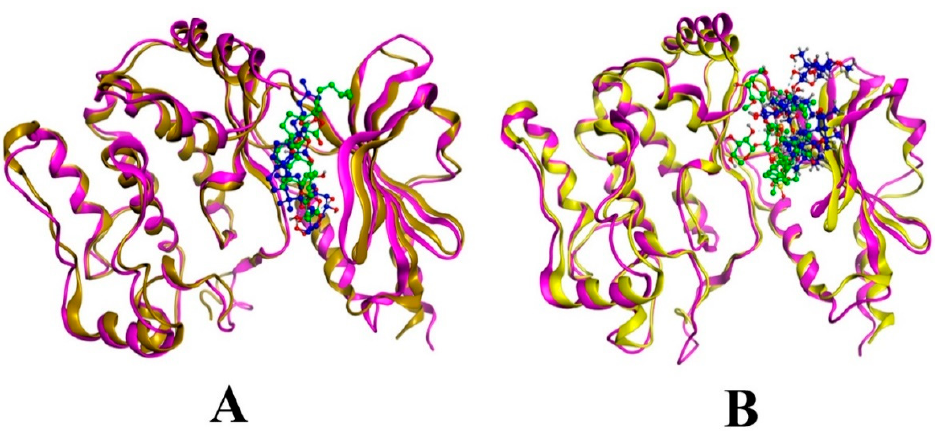
Figure 6. Ligand-protein complex poses after 20 ns molecular dynamics (MD) simulation compared to that of docked complexes. Receptor after molecular docking simulation: yellow; Receptor after 20 ns MD simulation: pink; Ligand after molecular docking simulation: green; Ligand after 20 ns MD simulation: blue; ( A ) DEB-PAK1 complex; ( B ) FRA-PAK1 complex. Table 5. No-bonding interactions of ligands with the catalytic domain of PAK1 obtained after 20 ns molecular dynamics simulation.